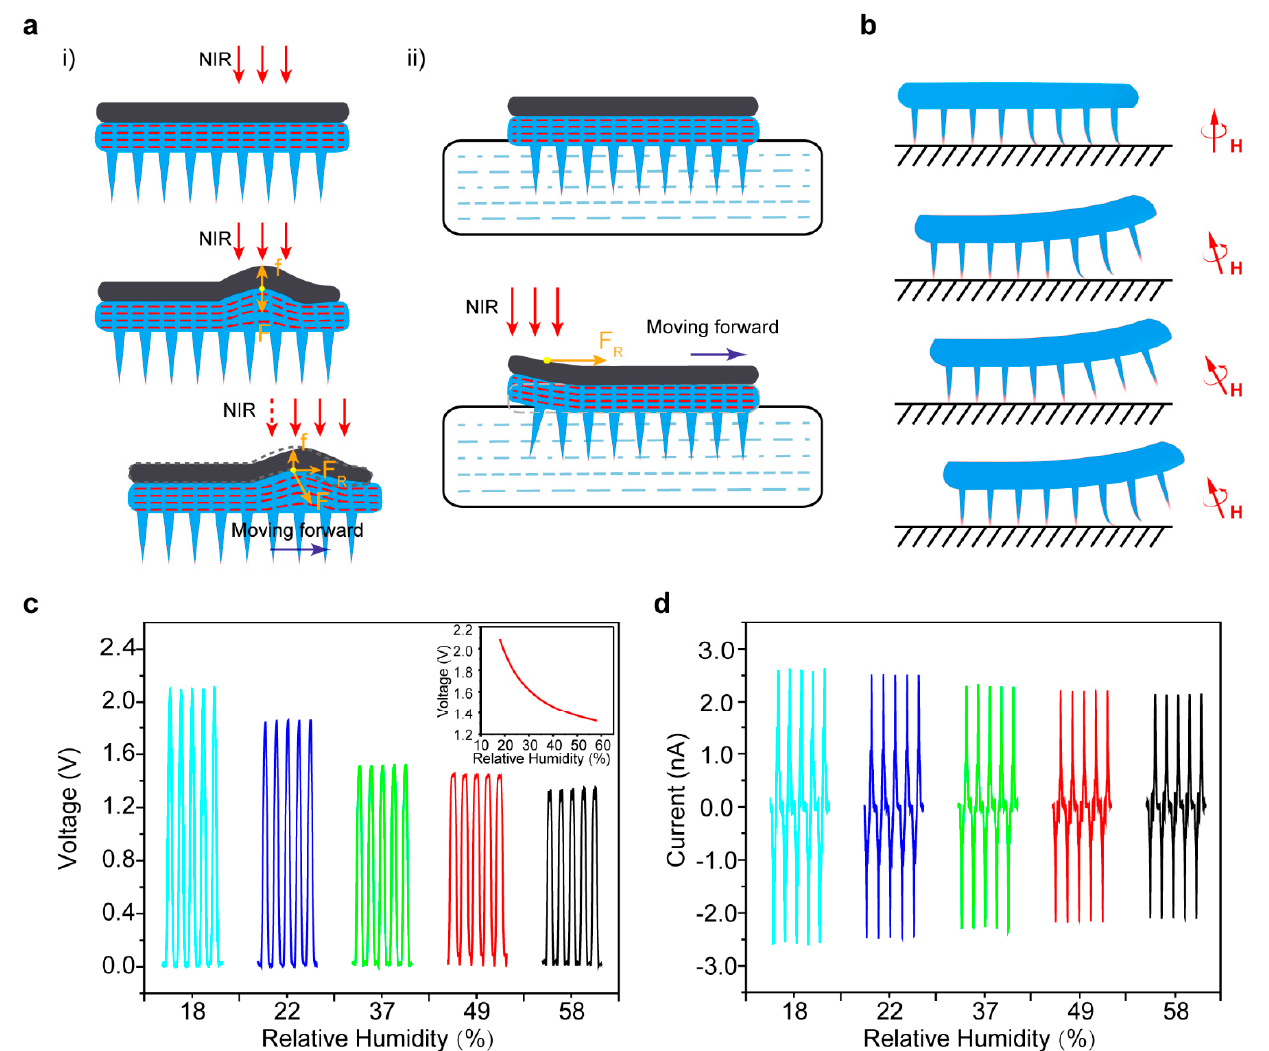
Figure 4. Locomotion analysis of the multi-legged soft millirobot and the signals harvests of millirobot-TENG. ( a ) Schematic diagram of the locomotion mechanism of the light-driven mode (i) walking and (ii) swimming. ( b ) Process of the millirobot motion with the magnetic field fluctuation. ( c ) Voltage signals harvested from the millirobot-TENG in different relative humidities; the inset depicts the fitting curve of the function between the voltage intensity and relative humidity. ( d ) Current signals harvested from millirobot-TENG in different humidities.